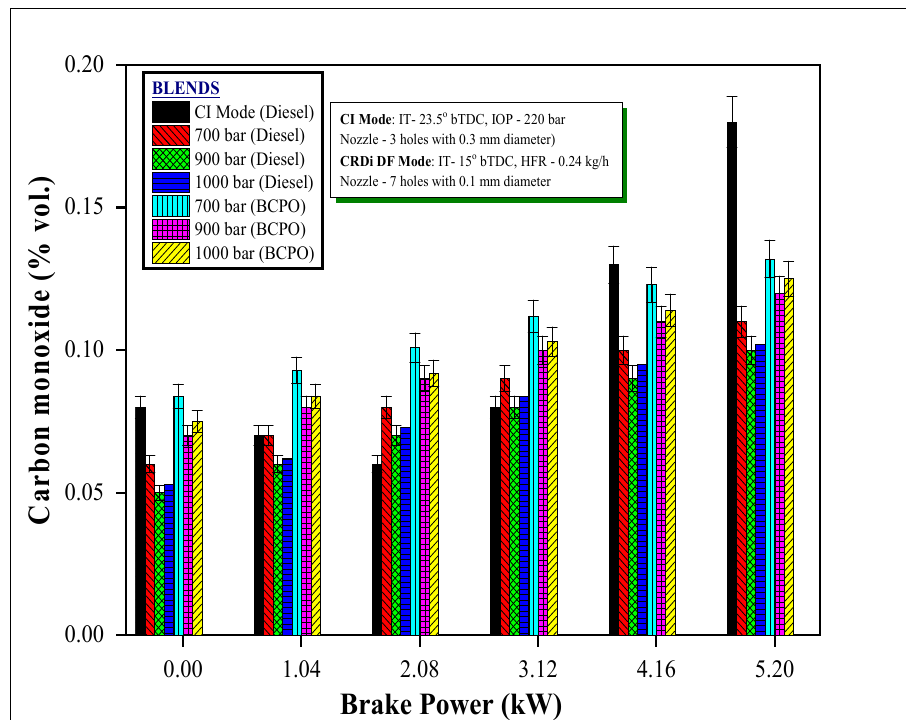
Figure 11. IP and BP influence on CRDi engine CO emissions.